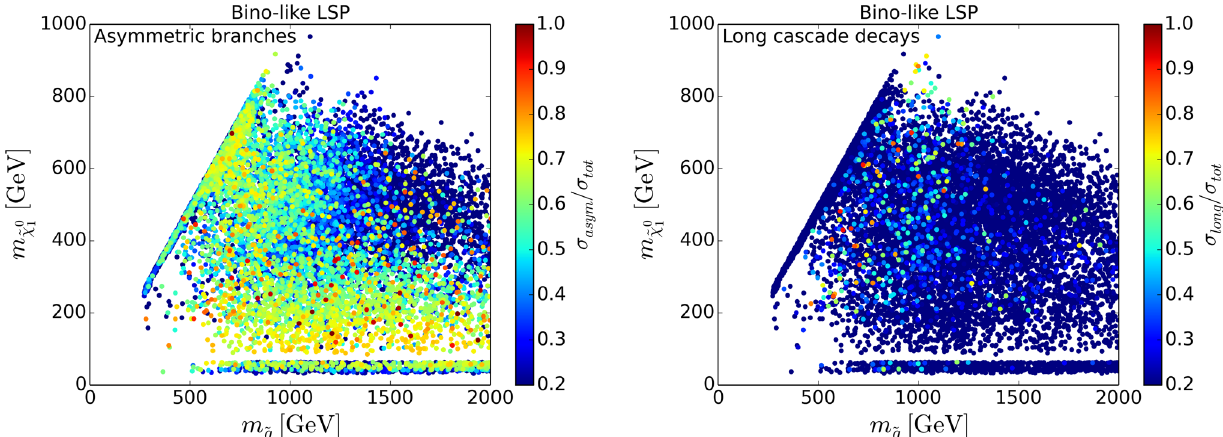
Fig. 4 Relative cross section in unconstrained decays with asymmet- ric branches (left) and long cascade decays (right), for scenarios with a bino-like LSP. Here the total cross section σ tot refers to the full 8 TeV